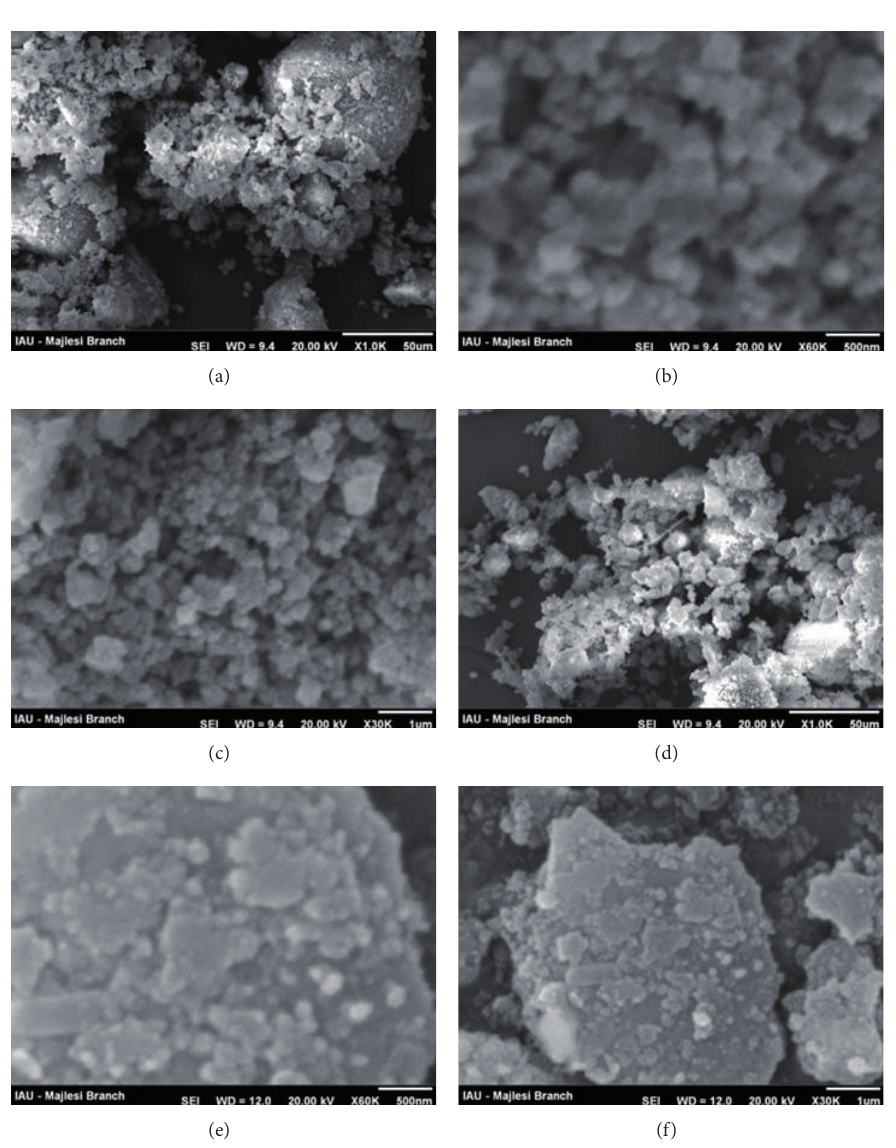
F 3: SEM images of nano-clinoptilolite (a–c) and SMZ